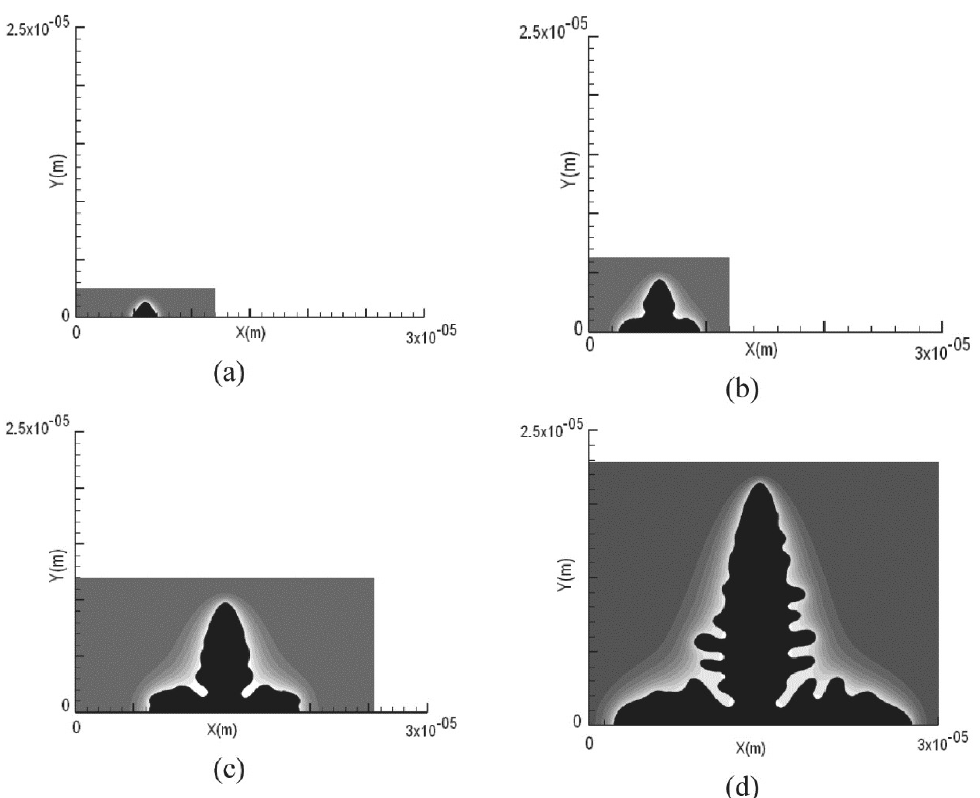
Figure 10. Development of the adaptive computational domain for dendritic growth for binary alloy ( Fe-C ). The numerical grids and solidification times are: (a) 85 points, 1.33×10 –5 sec; (b) 205 points, 7.01×10 –5 sec; (c) 400 points, 2.06×10 −4 sec; and (d) 605 points, 1.50×10 − 3 sec.